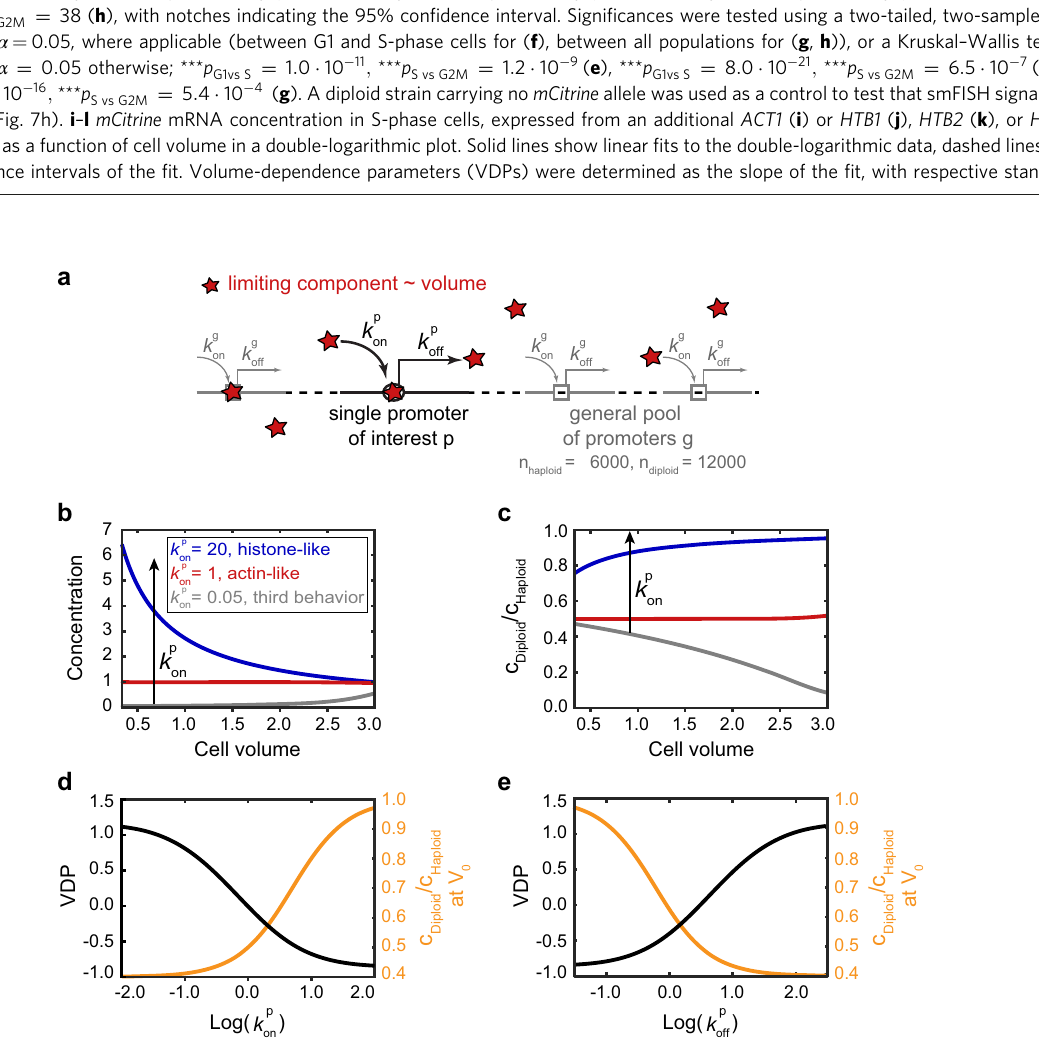
Fig. 5 Minimal model for the dependence of transcription rate of one speci fi c promoter of interest on cell volume and ploidy. a The model includes two classes of promoters: the general pool of promoters g and the speci fi c promoter of interest p with their respective initiation rates k p binding of the limiting machinery and off-rates k p keeping all other parameters fi xed ( c TM ¼ 2000 ; k g results in a qualitative change of the cell volume-dependence of transcript concentration obtained from the speci fi c promoter ( b ), as well as a change in the ratio between the concentration in diploid cells and the concentration in haploid cells ( c ). d , e Model prediction for the VDP (right, black) and for the ratio between the concentration in diploid cells and the concentration in haploid cells at a characteristic volume V 0 ¼ 1 (left, orange) as a function of k p ( e k p off